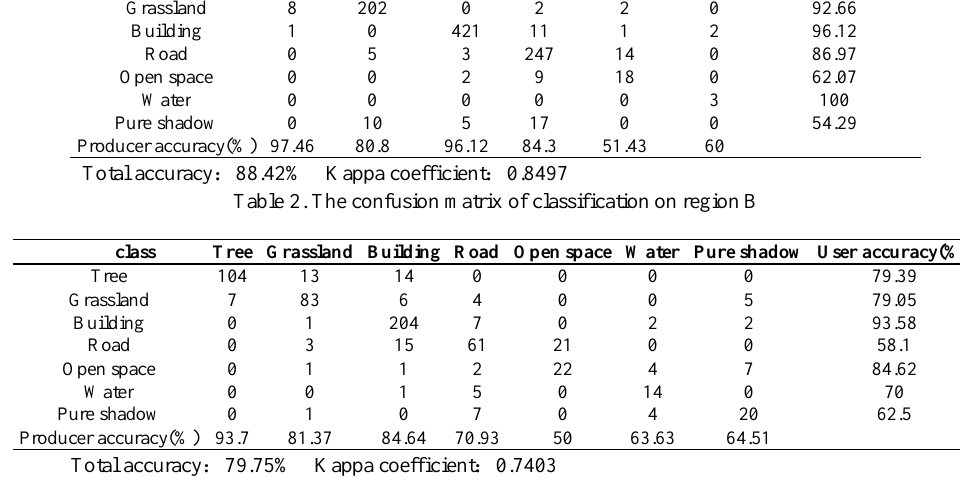
metabonomic toxicity classification: hierarchical cluster analysis and k-nearest-neighbour approaches.